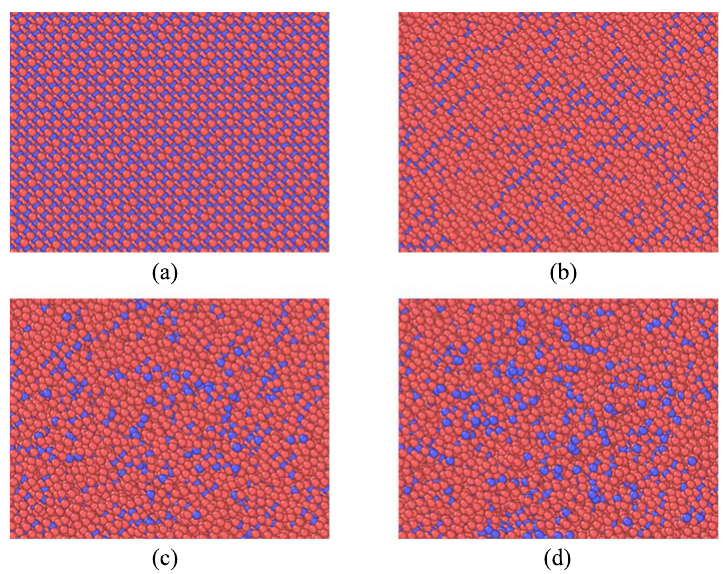
Figure 1. Top view of the atomic structure of SiC target before and after the helium bombardment. ( a ) the structure of perfect SiC bulk; ( b ) the structure of SiC bulk with 62 at % C concentration; ( c ) the structure of SiC bulk with 62 at % C concentration at the beginning of the bombardment; ( d ) the structure of SiC bulk with 62 at % C concentration after continuous He ions irradiation. The red balls represent C atoms, and blue balls represent Si